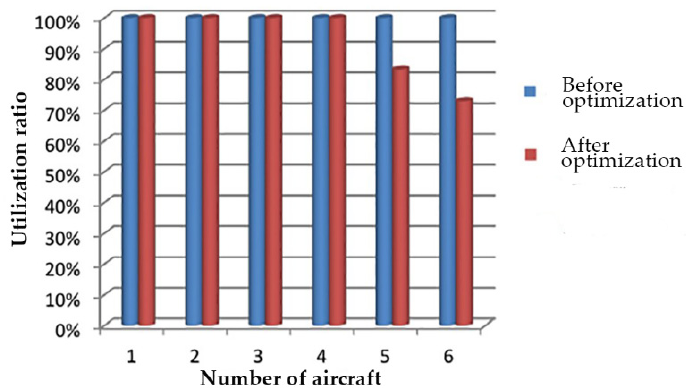
Figure 7. The relationship between the average utilization of refueling trucks and the number of aircraft before and after optimization.